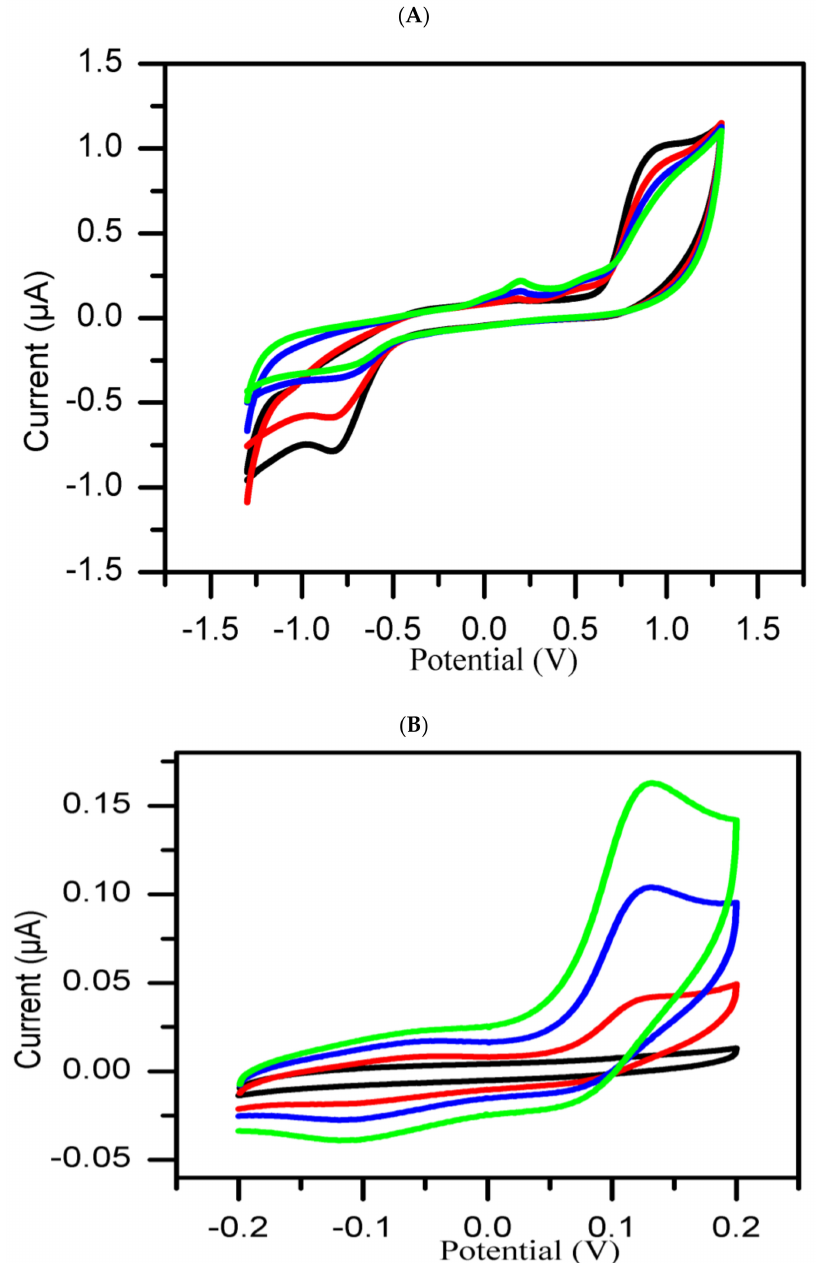
Figure 1. Overlay of CVs of mixture of tyrosine and tyrosinase in PBS (pH 6.5) recorded at 50 mV/s ( A ) and 25 mV/s ( B ) at different reaction durations: 0 min (Black curve), 10 min (red curve), 20 min (blue curve), and 30 min (green